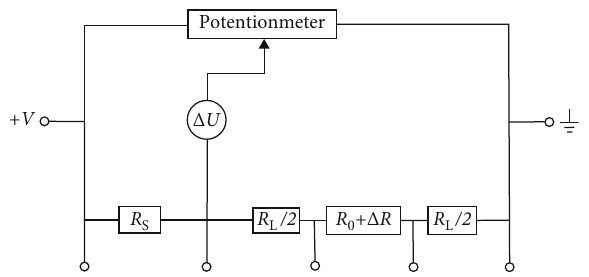
Figure 3: Schematic diagram of TPS (modi fi ed from ISO